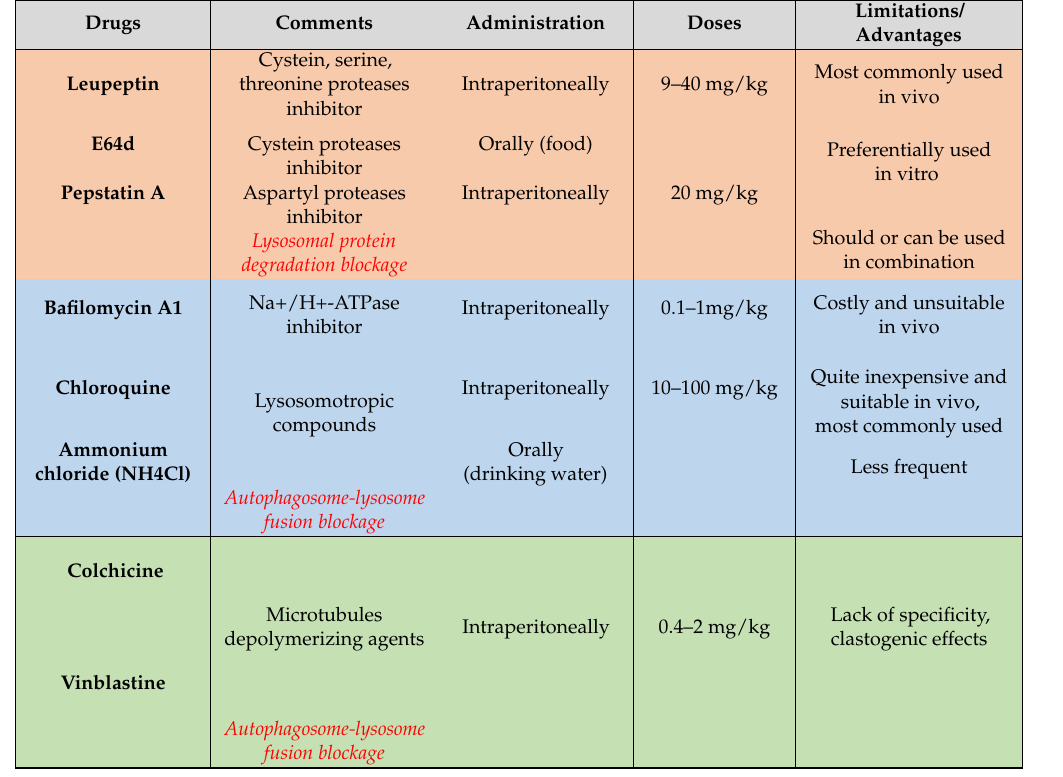
Table 2. Drugs targeting lysosomal blockade for measuring autophagy flux in